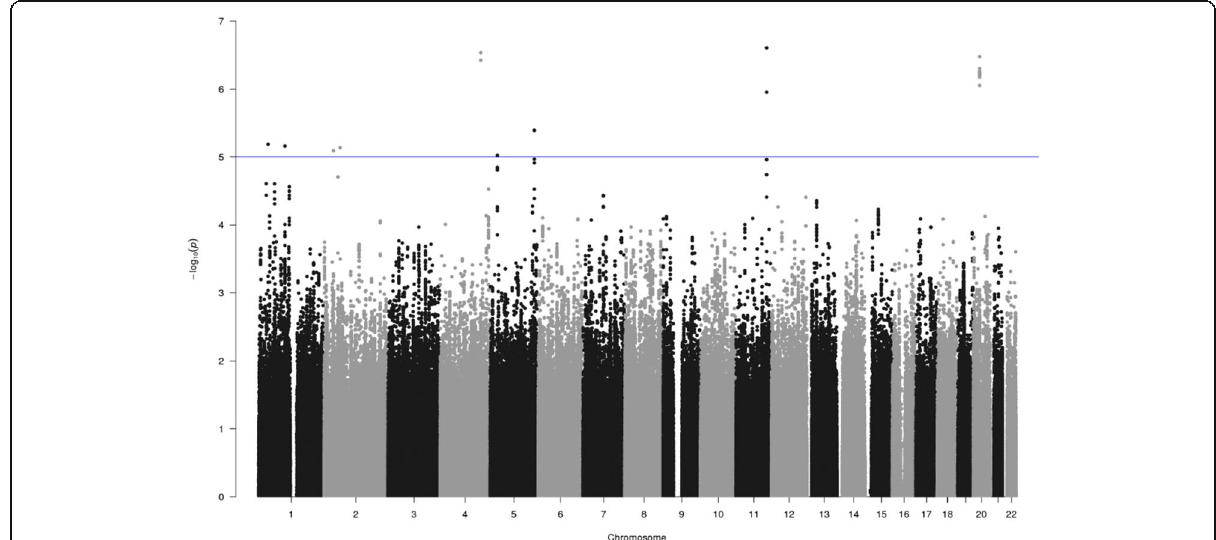
Fig. 2 pQTL analysis of SNPs associated with the change in circulating ANGPTL3 during weight loss. Manhattan plot of pQTL analysis of SNPs associated with the change in circulating ANGPTL3 during weight loss. Each SNP is indicated by a black or a gray dot. They are arranged by chromosomal location ( x -axis). The y -axis illustrates the level of statistical significance measured by the negative log of the corresponding p value for each SNP. The blue line represents suggestive association ( p < 1 × 10 − 5 )